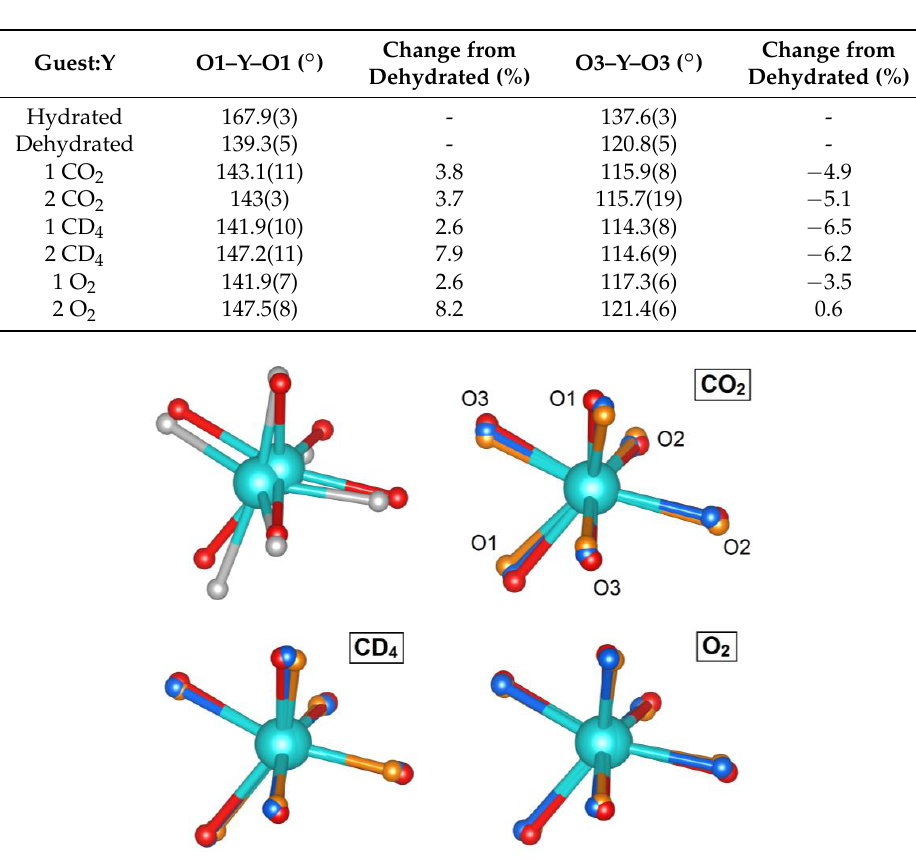
Figure 5. Graphical representation of the YO 6 coordination geometry site in Y(btc) under various guest loading conditions. Y is represented by light blue spheres. The O1, O2 and O3 positions are depicted for the hydrated structure (light grey), empty structure (red), and guest-dosed structures at 1 guest:Y (dark blue) and 2 guest:Y (orange) loading concentrations.